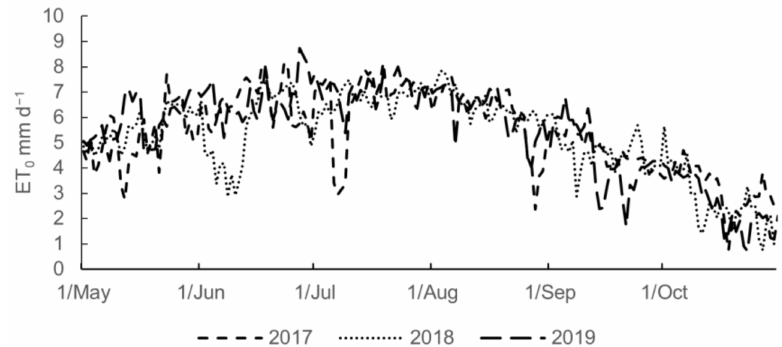
Figure 3. ET 0 daily values for the irrigation seasons 2017, 2018, 2019.